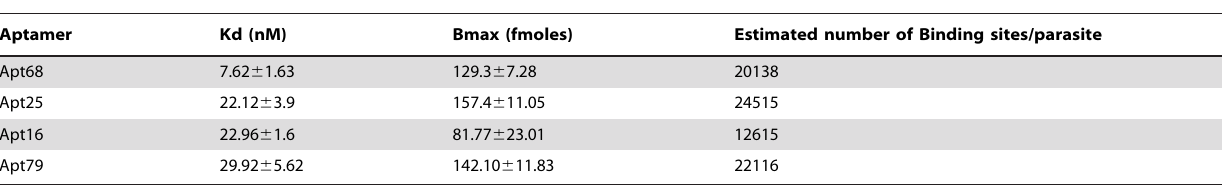
Figure 2. Binding analysis of aptamers with T.cruzi trypomastigotes. A representative clone (Apt16, 25, 68 and 75) from each aptamer family, obtained at round 12 of SELEX was used in radiolabeled binding studies. 32 P-GTP labeled monoclonal aptamers at varying concentration beginning at 100 nM were incubated with a fixed number of trypomastigotes (2 6 10 6 parasites) in a 200 m l reaction. After the parasites were washed with SELEX buffer, the amount of aptamers bound to the parasites were determined as described in Materials and Methods. Specific activity of the labeled aptamer was used to calculate the fmole amount of aptamer bound to the parasites. Each data point represents triplicate values and the error bars represent the standard deviation. Apt16 (A), Apt25 (B), Apt68 (C) and Apt79 (D) all showed dose depended saturable binding to the parasites while the respective scrambled controls showed linear non-specify binding. The saturating curve obtained was analyzed using GraphPad Prism 5, under the non-linear fit model (global fitting of total and nonspecific), with specific (aptamer) and nonspecific (scrambled aptamers, Apt Sc) binding, and Bmax and Kd were calculated (Table 1). doi:10.1371/journal.pone.0043533.g002 Apt68 Interacts with High Specificity to T. cruzi Trypomastigotes Of the aptamers tested in the initial binding assays, Apt68 demonstrated the highest affinity (Kd 7.68 6 1.63 nM). Based on Table 1. Binding characteristics of the selected